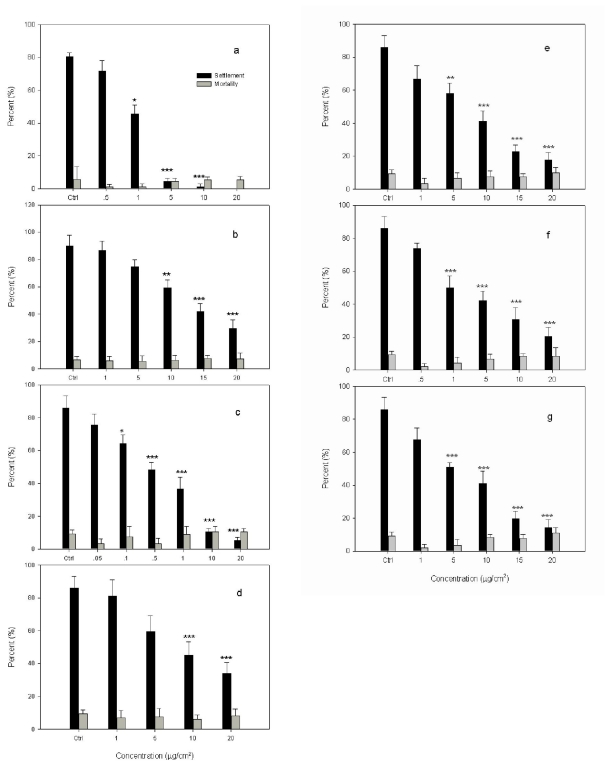
Effects of compounds on settlement and survival of B. albicostatus cyprids. a: Capsaicin; b: 8(14)-enyl-pimar-2′(3′)-en-4′(18′)-en-15′(16′)-en-dolabr-16,15,2′,3′-oxoan- 16-one (1); c: Tagalsin C (2); d: Tagalsin I (3); e: lup-20(29)-ene-3β,28-diol (4); f: 3-oxolup-20(29)-en-28-oic acid (5); g: 28-hydroxylup-20(29)-en-3-one (6). Data were analyzed using one-way ANOVA, where *P < 0.05; **P < 0.01 and ***P < 0.001 were significantly different from the negative control.